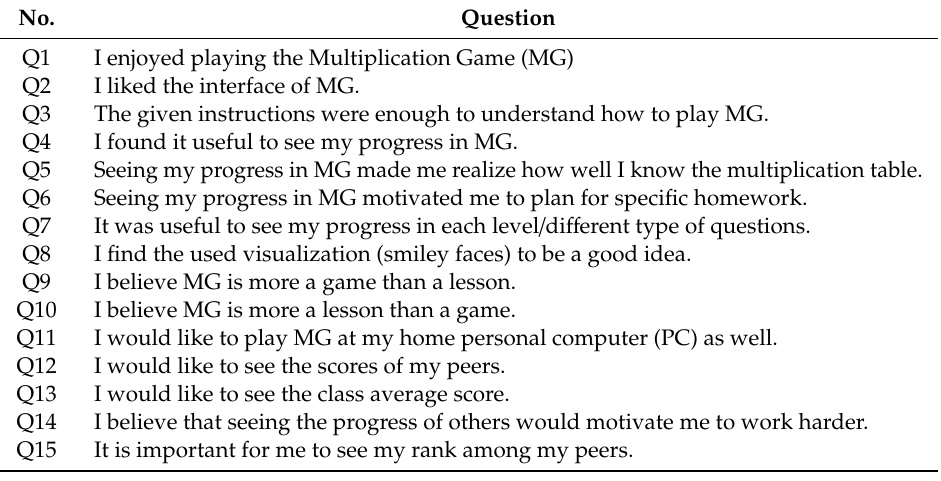
Table 1. Questionnaire used for assessing the Multiplication Game (MG) v.2.